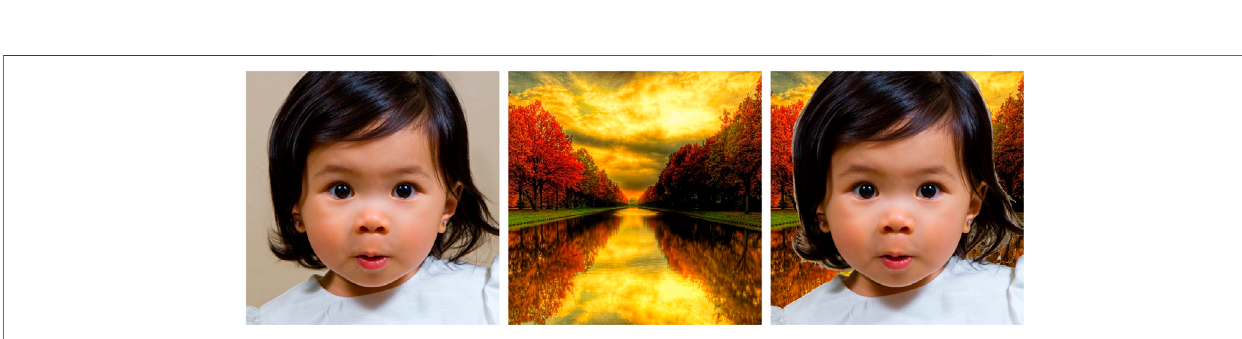
FIGURE 4 | GradCAM visualization for ResNet50-NoDown (Gragnaniello et al., 2021) before (top) and after (bottom) image splicing.